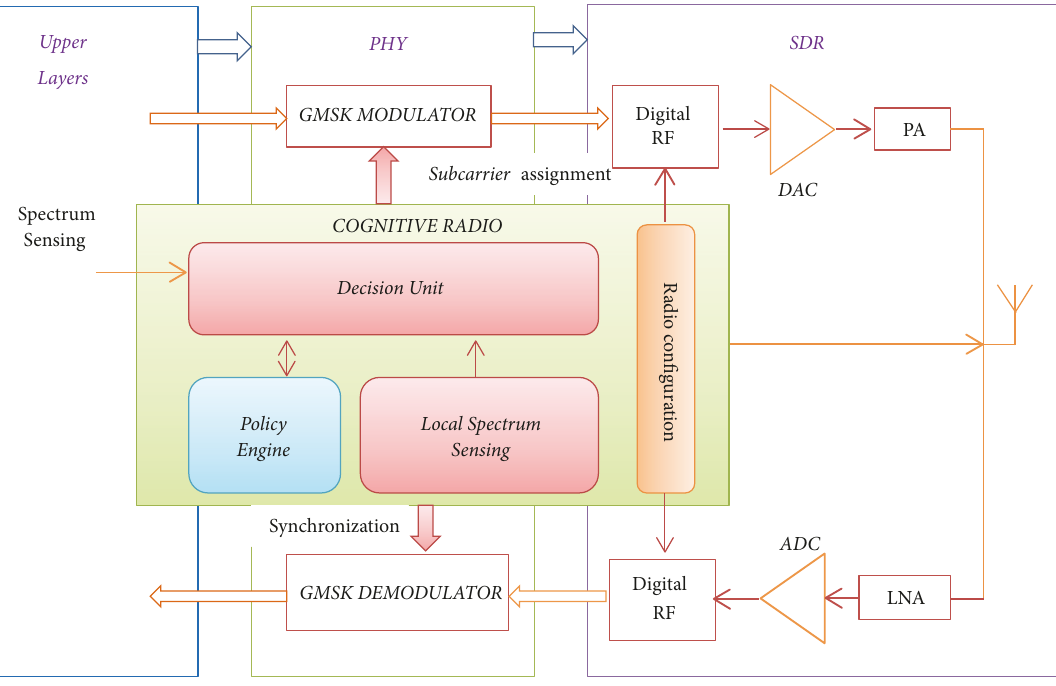
Figure 1: Overall system block diagram.